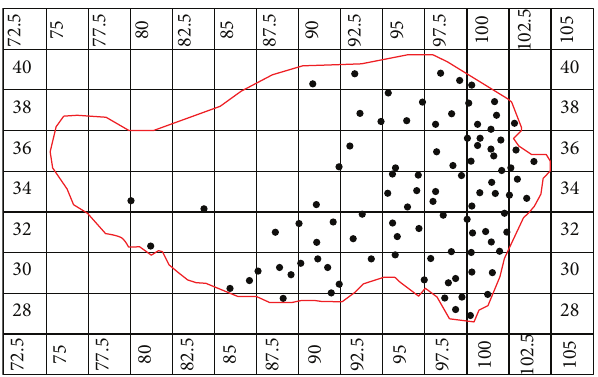
Figure 1: Grid patterns of the GFCM21 climate models on the Tibetan